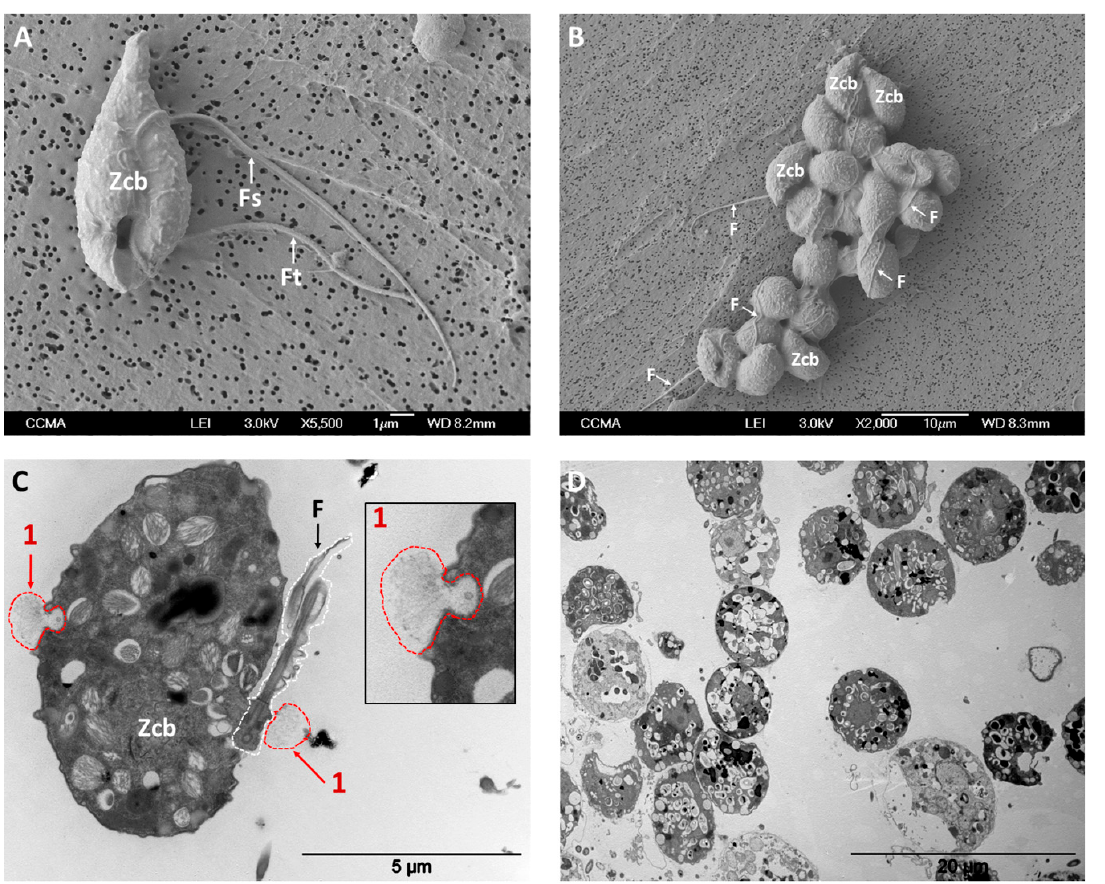
Figure 1. Micrographs of P. parasitica zoospores at unicellular stage, taken in absence of K + (panels A and C ) and of cell aggregates, taken at t = 15 min after K + application (panels B and D ). Zoospore cell bodies and flagella are indicated with “Zcb” and “F”, respectively. “Fs” and “Ft” indicate smooth and tinsel flagella, respectively. Panel C shows two secretory events (1); the inlet depicts a secretory vesicle that has just secreted its fibrillary content. Panel B shows the presence of several and representative ellipsoidal cells (such as those indicated as “Zcb”) and interwoven flagella (F), indicating a prominent proportion of cells at the zoospore stage in aggregates. Images were obtained through scanning electron microscopy (SEM; panels A and B ) and transmission electron microscopy (TEM) on analyses of 80-nm-thin sections (panels C and D ) in presence or absence of K +